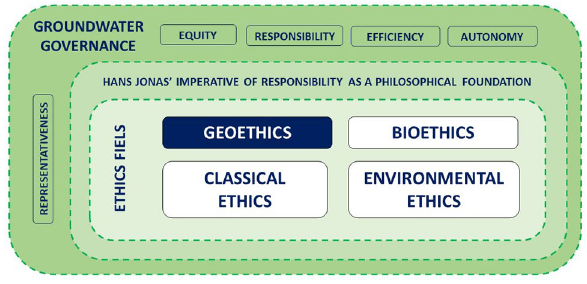
Fig. 1 Interactions between groundwater governance and ethics fields and its philosophical